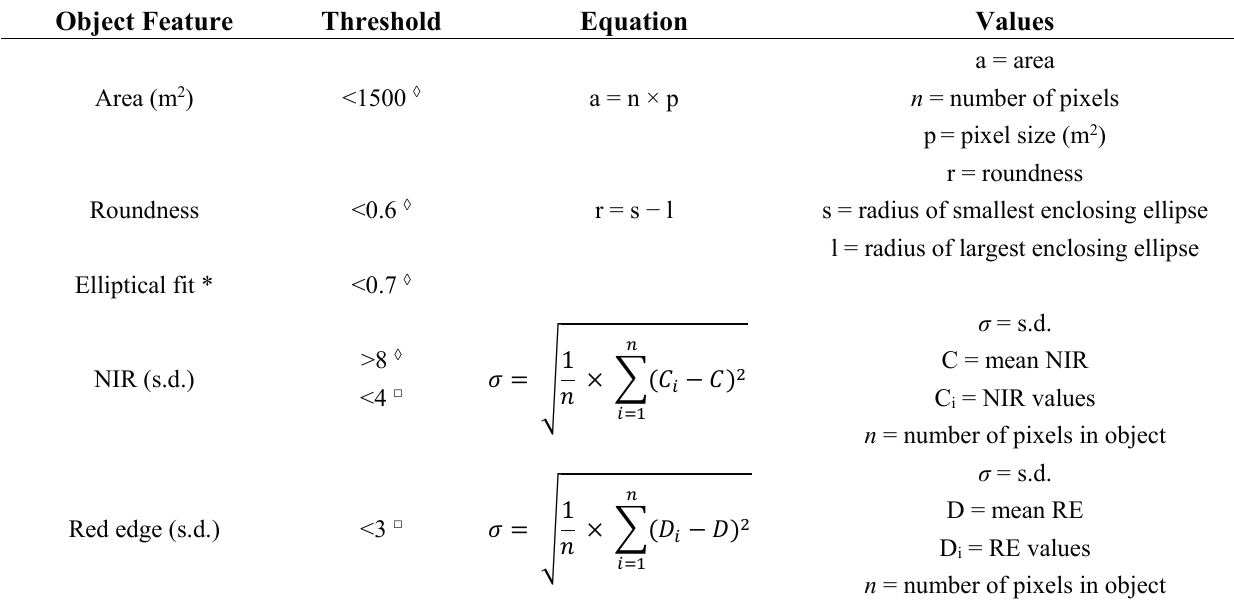
Table 4. Object features used for tree mask generation and tree crown